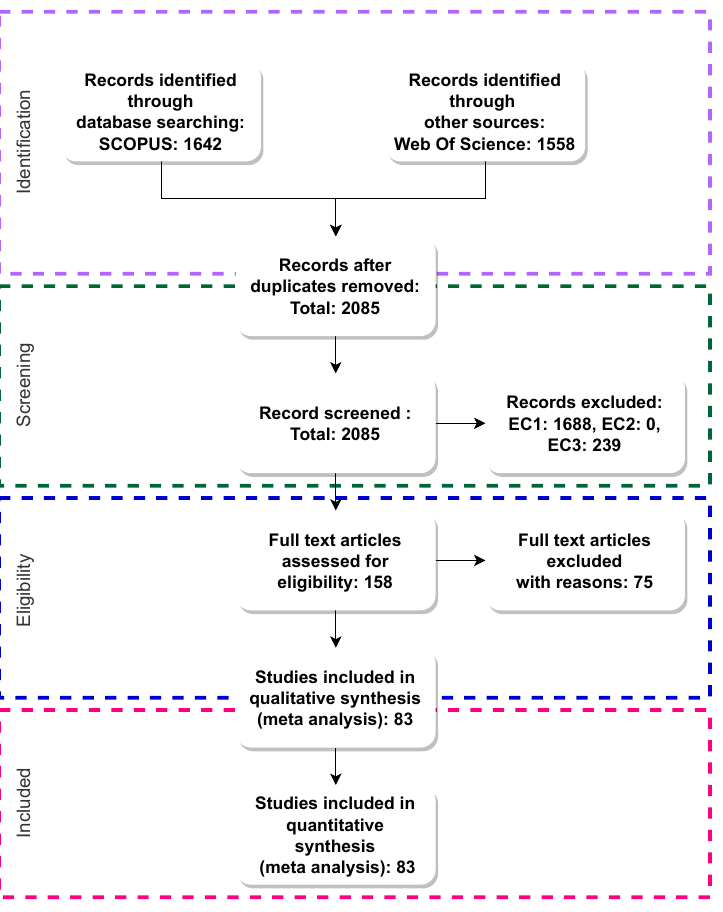
Figure 1. PRISMA Flow